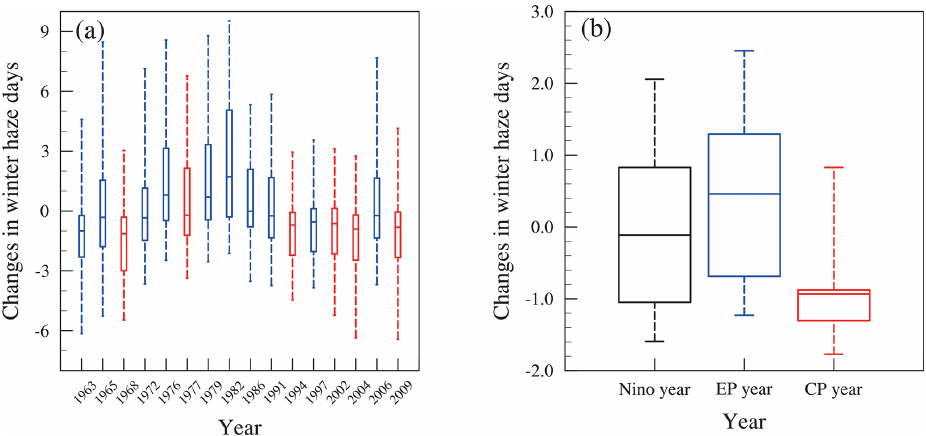
Figure 3. Box-and-whisker plots of (a) WHD anomalies at all sites over the JJJ region in each El Niño year and (b) site-averaged WHD anomalies in different types of El Niño years (unit: day). Each site-averaged WHD anomaly was sampled from a single El Niño year, and all these anomalies were divided into groups named Niño year, EP year, and CP year. The blue, red, and black lines represent the EP, CP, and all El Niño years, respectively. Each box and whisker consists of the 5th percentile (the lower point of the whisker), 25th quantile (the lower border of the box), median (horizontal line in the middle of the box), 75th quantile (the upper border of the box), and 95th percentile (the upper point of the